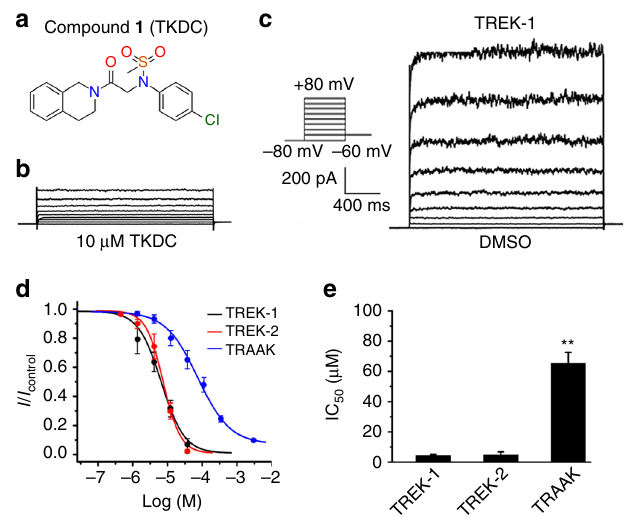
Fig. 1 Inhibition of TREK subfamily channels by TKDC in CHO